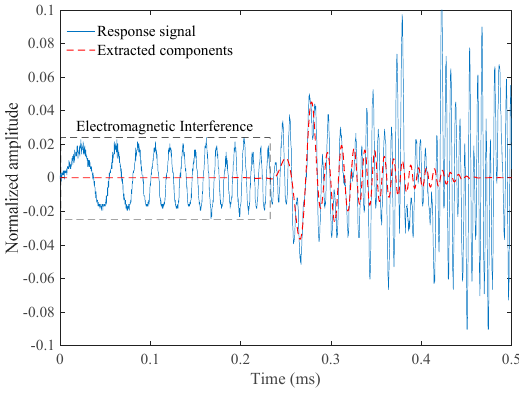
Figure 7. The broadband response signal and the extracted direct wave of A0-mode Lamb wave.